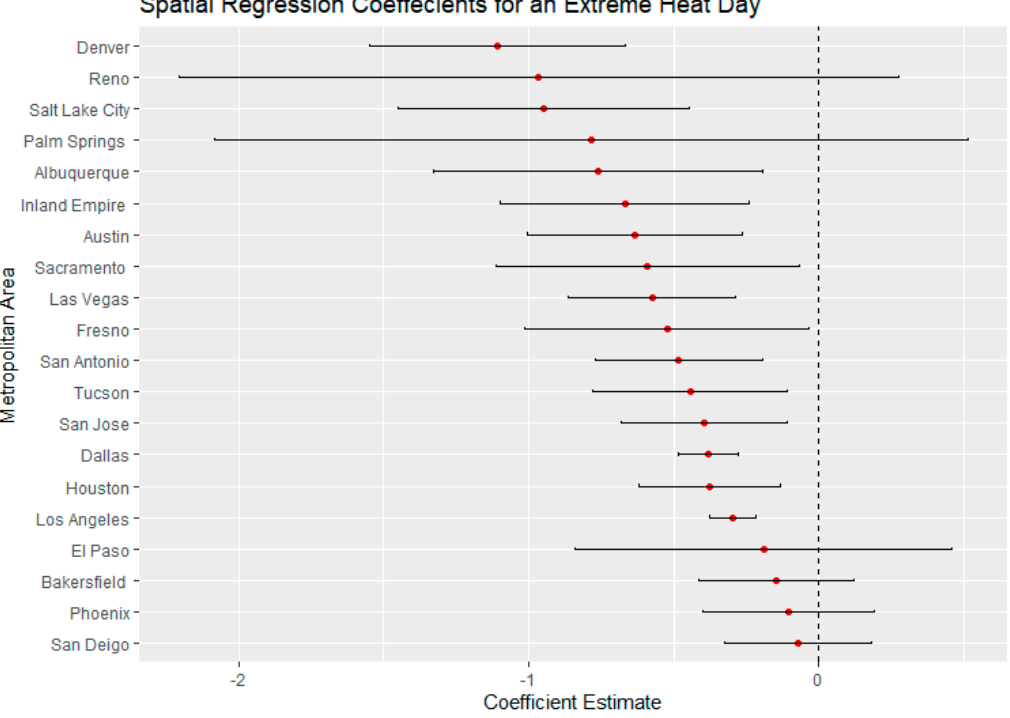
Figure 6. Spatial regression coefficients for median income during an extreme heat day in 20 Southwest metropolitan areas.